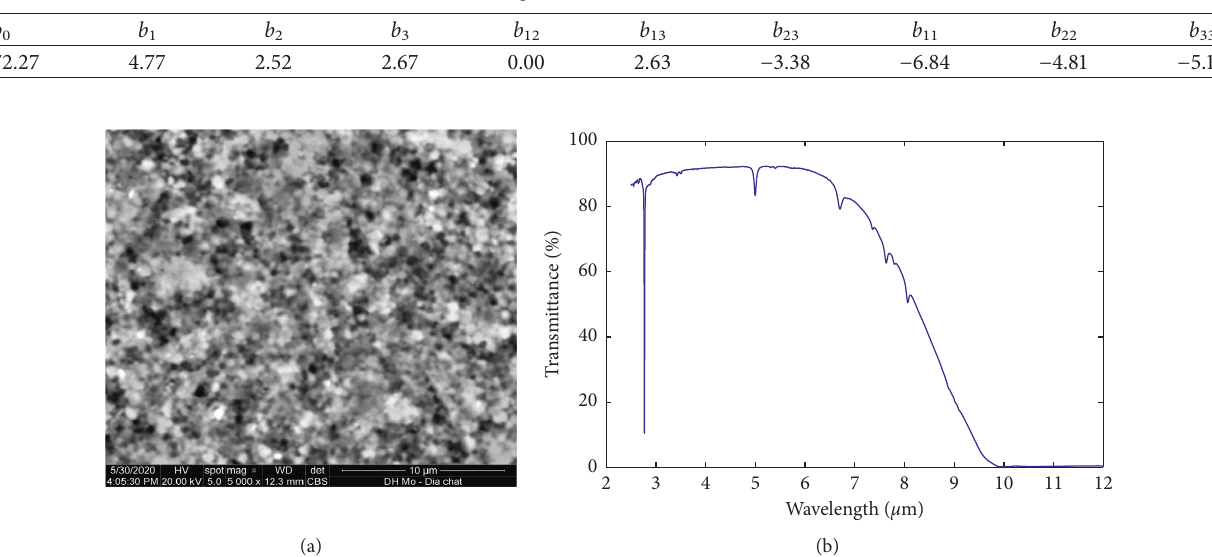
Table 6: The regression function coefficient values.